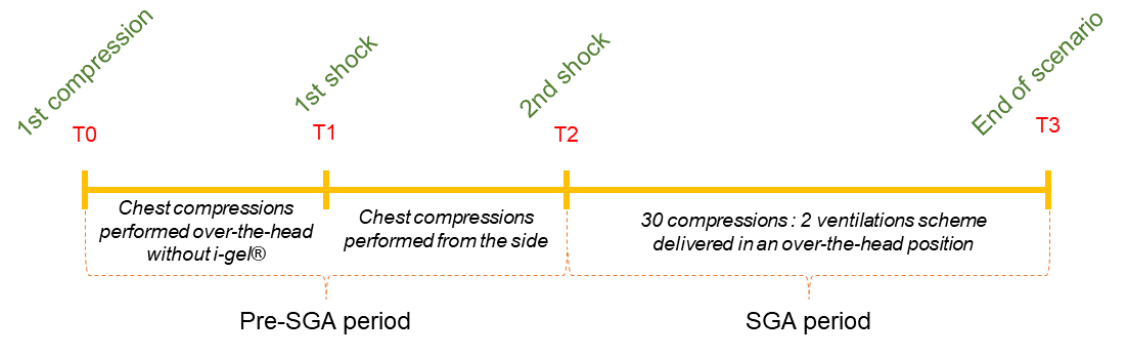
Figure 1. The periods of